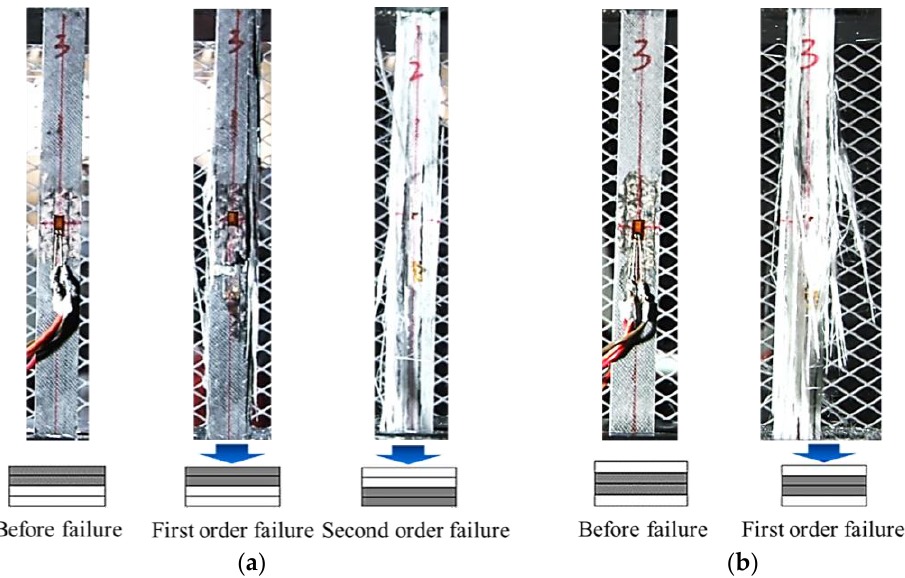
Figure 6. Failure process of the interlayer hybrid composites: ( a ) [G/G/C/C]; ( b ) [G/C/C/G]. Note: The arrow refers to the observation surface of the samples.